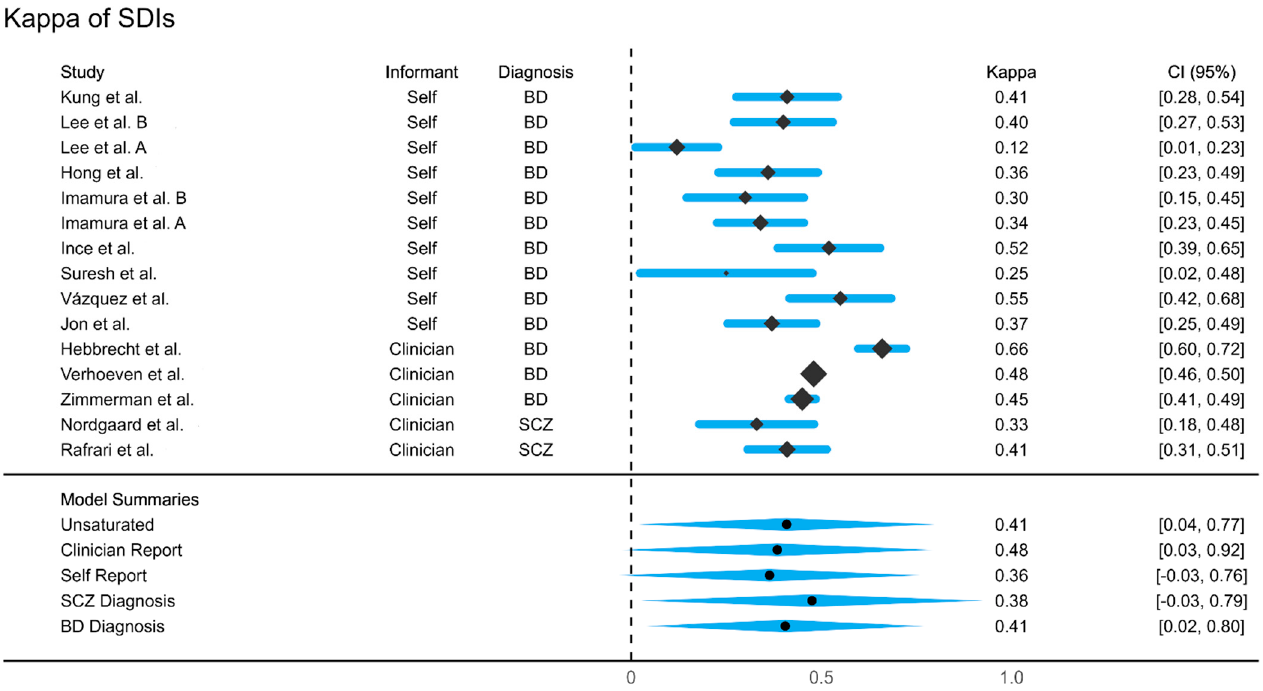
Figure 4. Trim and fill funnel plot. White dots indicate implied missing studies, [45,47,49–51,53,55– 57,60–63].